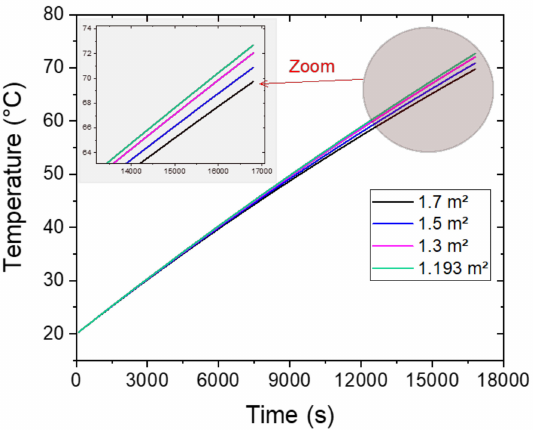
Figure 5. Temporal variation of water temperature for different external areas.